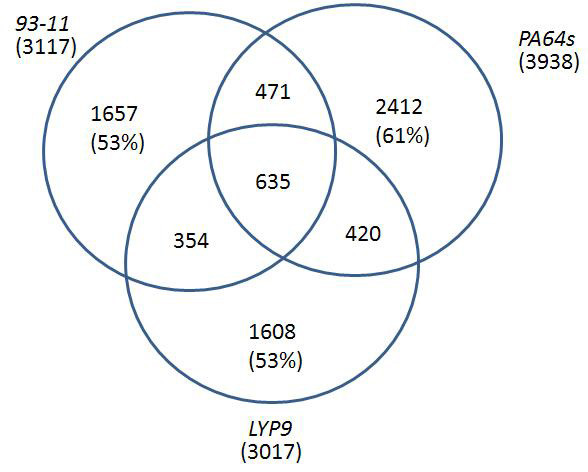
Venn diagrams of unigenes shared among libraries based on unigene counts.